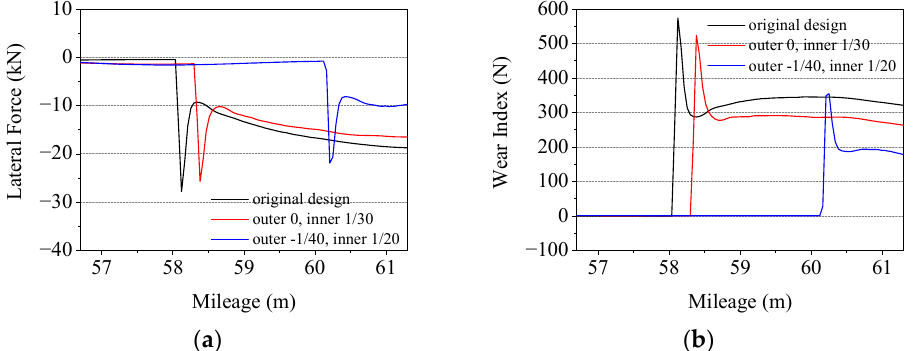
Figure 9. Calculation results of wheel–rail lateral force and wear index under different rail cant combination designs. ( a ) Lateral force; ( b ) Wear index.